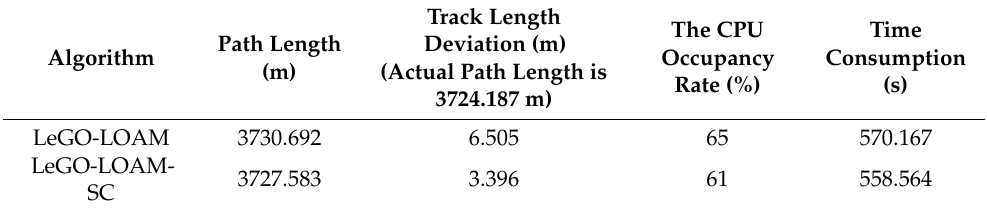
Table 1. Track length and the deviation, CPU occupancy and time consumption by the two algo ‐ rithms.